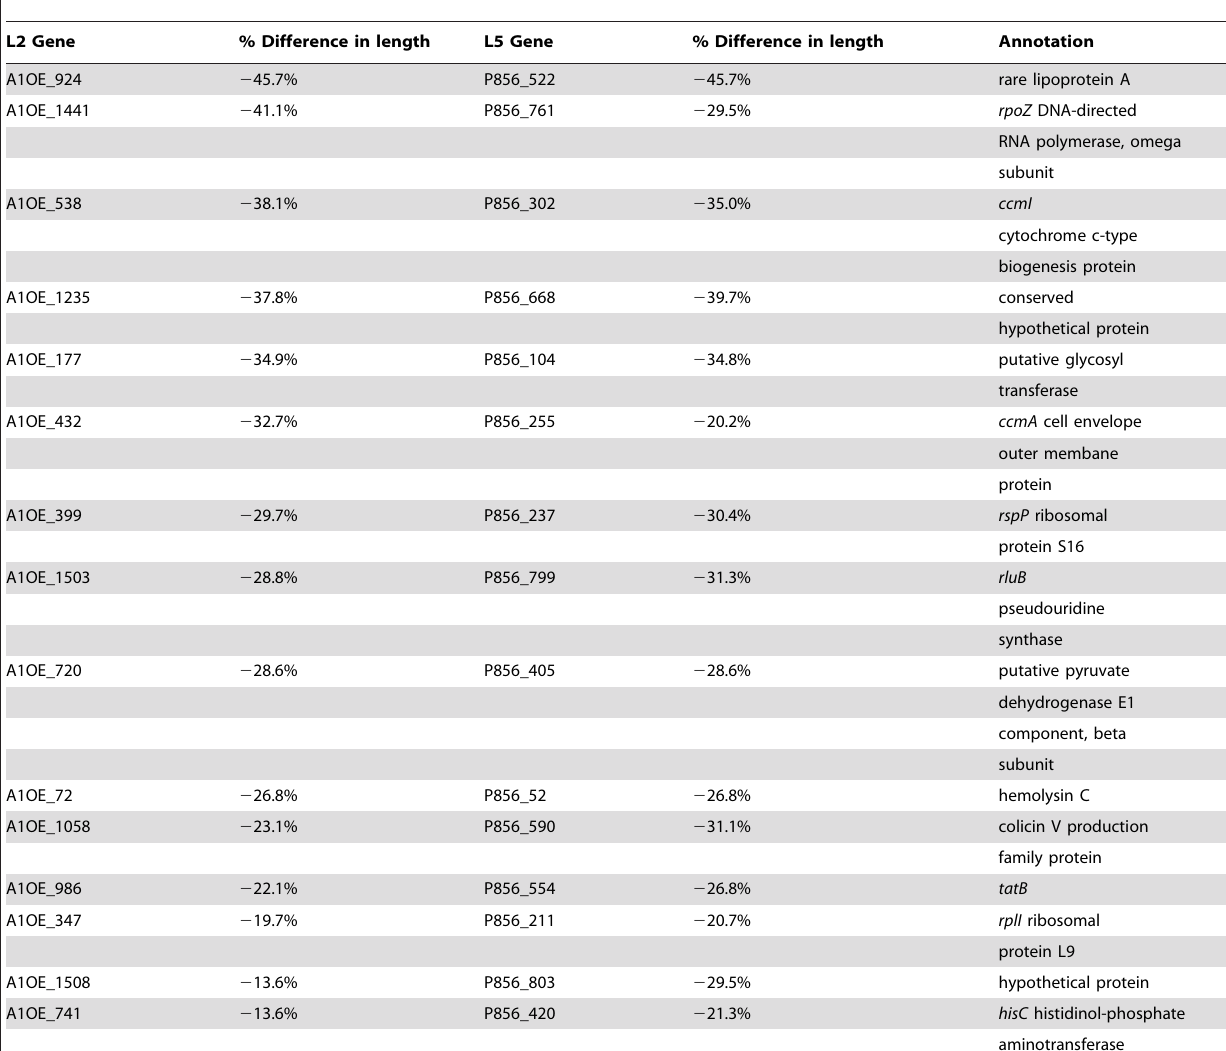
Table 4. Ca. E. faulkneri genes that are more than 20% shorter than their homolog in BAL199 in at least one strain.